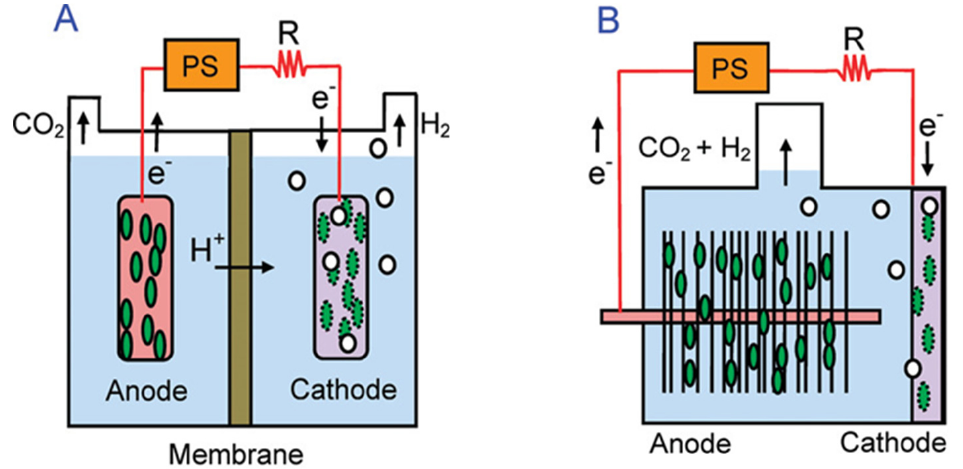
Figure 2. Schematics of ( A ) two–chamber (flat anode) and ( B ) single-chamber membraneless (brush anode) MECs. Reproduced with permission from ref.